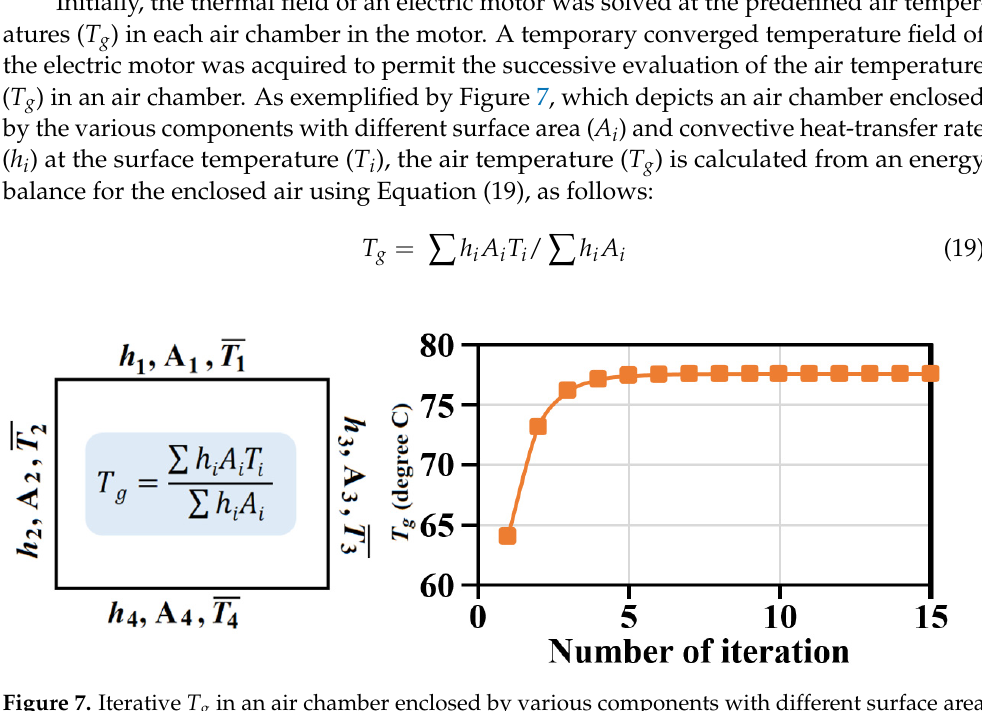
Figure 7. Iterative T g in an air chamber enclosed by various components with different surface area ( A i ) and convective heat-transfer rate ( h i ) at the surface temperature ( T i ).